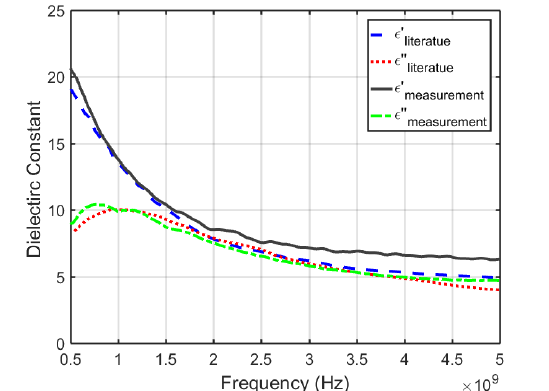
Figure 9. The bearing ball imaging experiment setup: ( a ) sunflower oil, ( b ) the bearing ball and its base, ( c ) the ethanol container, attached to the NRIMS and partially submerged in oil, ( d ) the oil container.